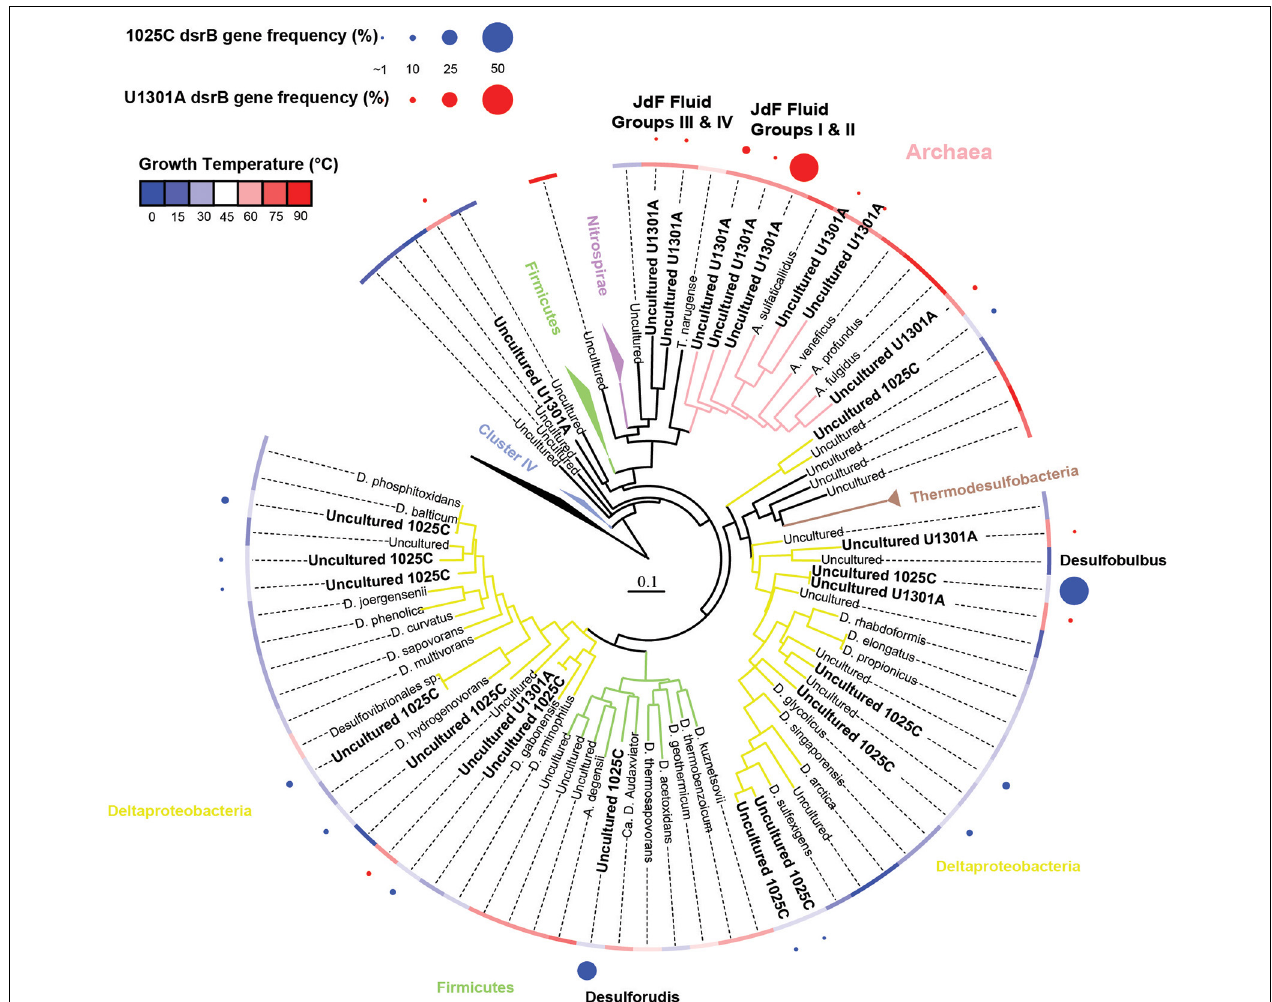
FIGURE 5 | Phylogenetic relationships of dsrB sequences from borehole 1025C and U1301A fluids. Gene clones identified in this study are highlighted in bold; the relative abundance of identical clones recovered from the same sample is indicated by circle size. Tree branches are colored according to the